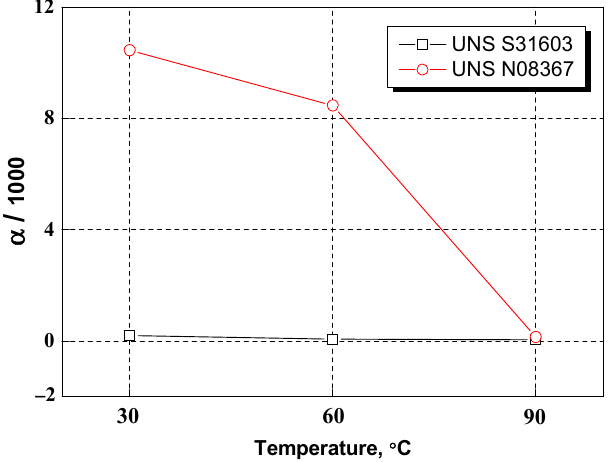
Figure 10. Alpha( α ) value UNS S31603 and UNS N08367 after electrochemical experiment in modified green death solution with temperature.